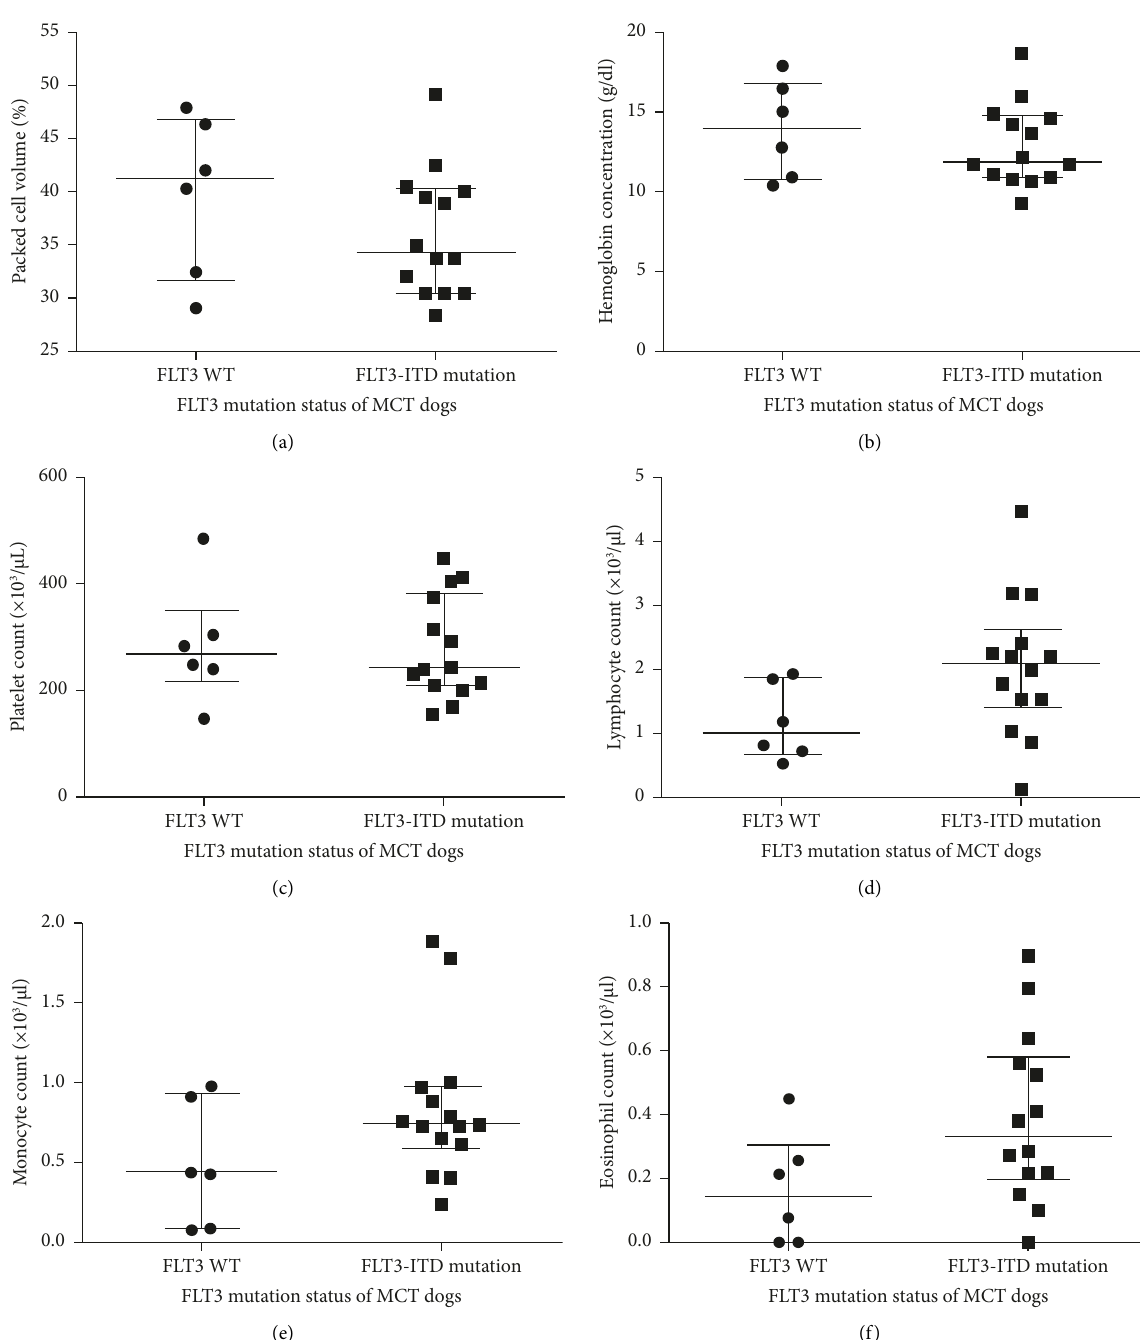
Figure 3: Hematological parameters in FLT3-WT and FLT3-ITD mutated dogs. Dot plots showing packed cell volume (a), haemoglobin concentration (b), platelet count (c), lymphocyte count (d), monocyte count (e), and eosinophil count (f) data of FLT3-WT ( n � 6) and FLT3-ITD mutated ( n � 14) dogs. No significant differences were observed between the two groups considering all haematological